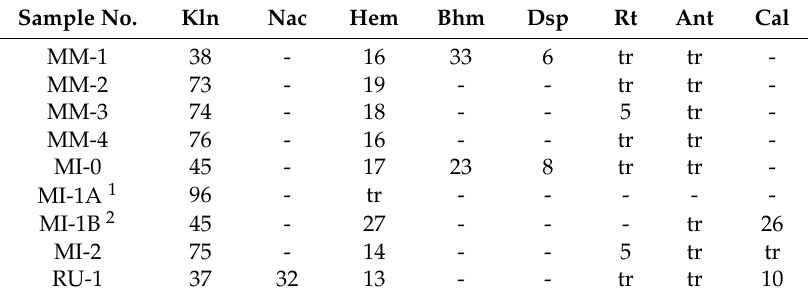
Table 3. Semi-quantitative mineral composition obtained by XRD-analysis (wt %) of the studied bauxitic samples from the